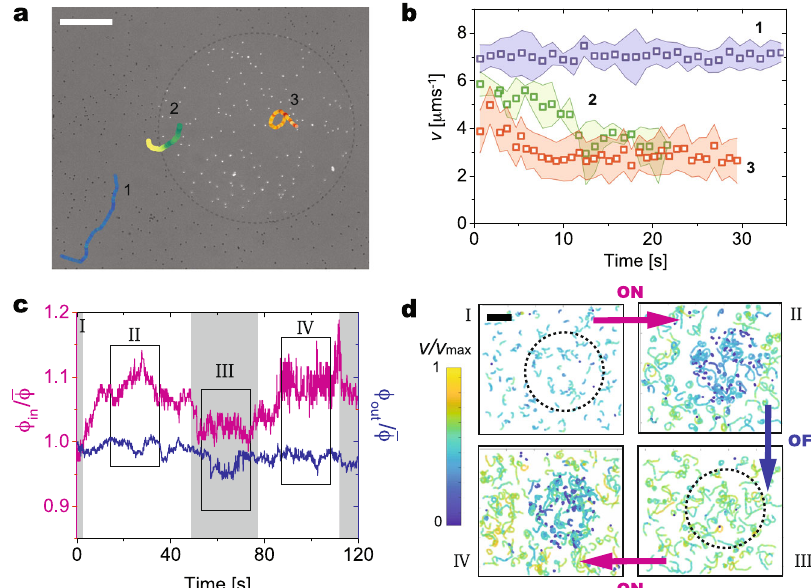
Fig. 5 Adapting swimming to light patterns. a Combined transmission and epi fl uorescent micrograph of self-propelling dumbbells where the fl uorescent light ( ρ FL = 0.2 mW(mm) − 2 ) is con fi ned within the dashed circle by partly closing the microscope diaphragm. Characteristic trajectories of active particles remaining outside (light blue to dark blue) or inside (red to yellow) the illuminated region, or crossing from one to the other (yellow to green). The trajectories are color-coded based on the instantaneous velocity. Upon entering the illuminated region, the dumbbell clearly slows down. Scale bar: 150 μ m. b Particle velocities (absolute values) as a function of time for the three representative particles depicted in ( a ), using the same colors. Time t = 0 s corresponds to the fl uorescent light being turned on. The shaded bands represent the error bars corresponding to the standard deviations of the instantaneous particle velocity over 0.4 s (four frames). c Particle number density inside ϕ in (red – left axis) and outside the illuminated region ϕ out (blue – right axis) versus time during on (white) and off (gray) cycles of the fl uorescent light. The number density is normalized by the initial number density, (cid:1) ϕ , of a uniform particle distribution before turning on the fl uorescent light. The data are produced by cumulating three independent experiments. d Particle trajectories during the on – off cycles corresponding to the boxed regions in ( c ) color-coded by instantaneous velocity (averaged over four frames) for 50 frames (I) and 200 frames (II, III, IV). During the on cycles, the particles within the illuminated region signi fi cantly slow down and the persistence of their trajectories drops. During the off cycles, they return to their original swimming behavior. The particles outside the illuminated region are not affected. Scale bars represent 40 μ